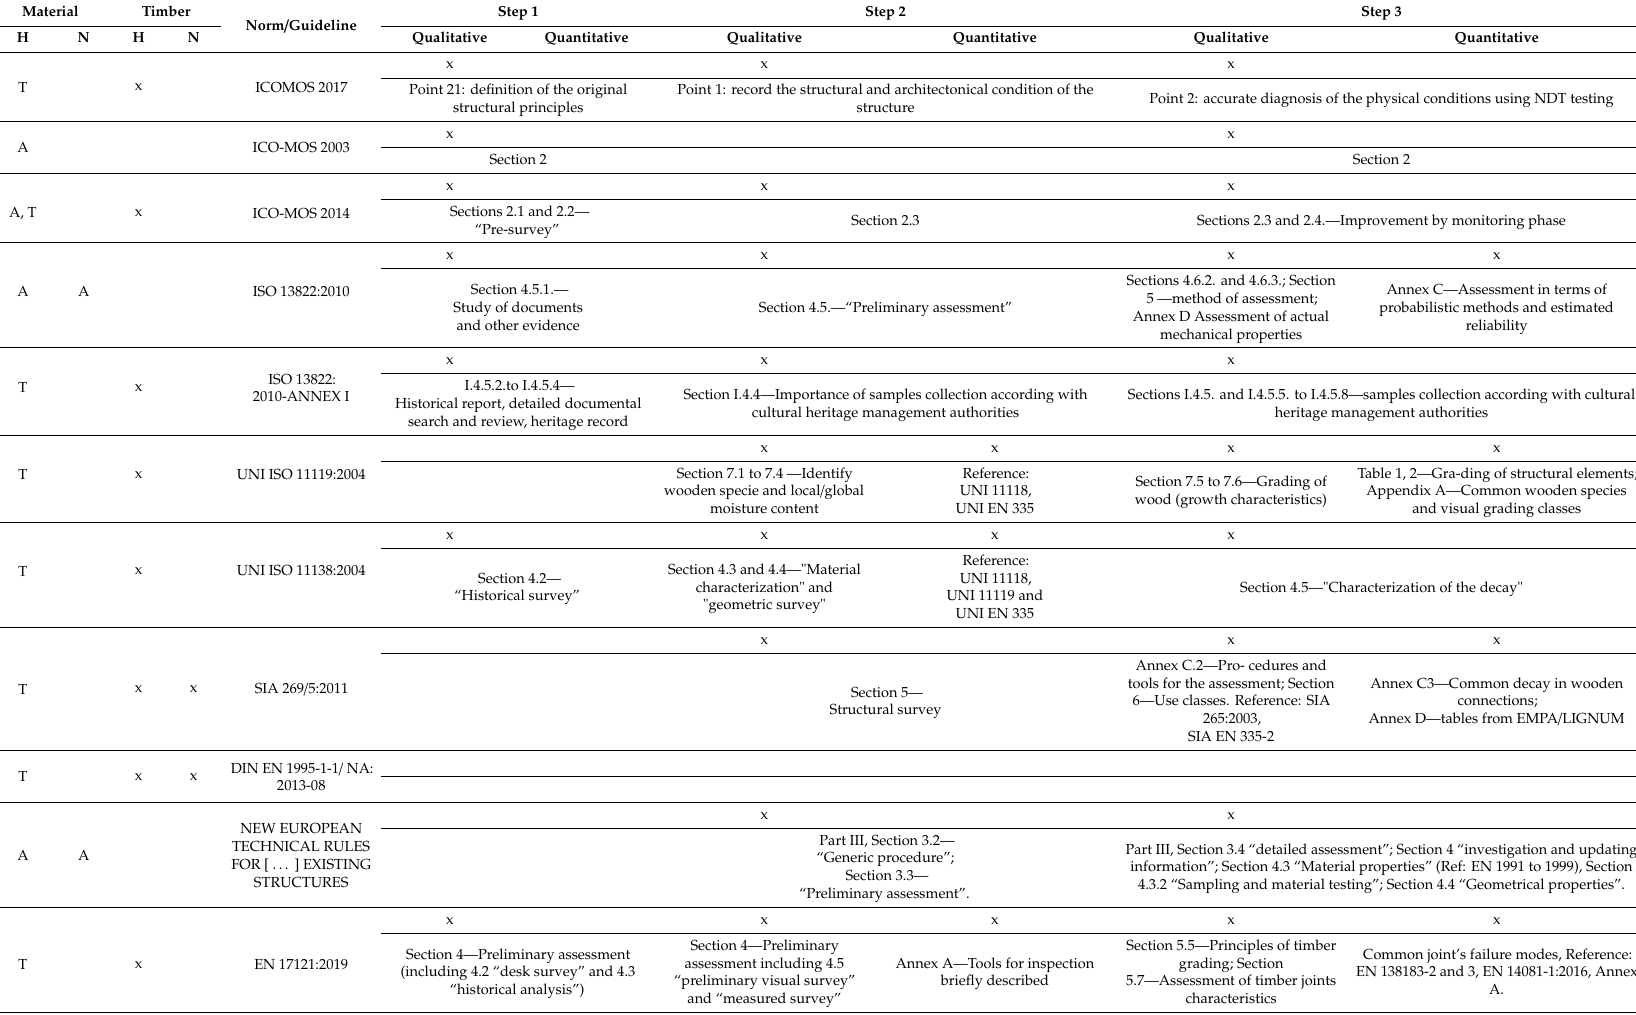
Table 2. R é sum é of the content of the analyzed standards—Step 1 to Step